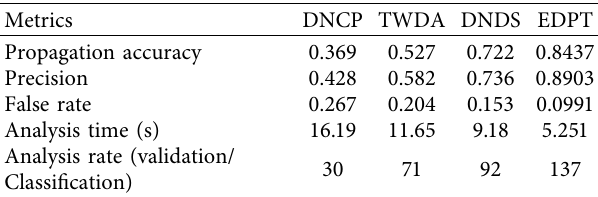
Table 3: Discussion summary for